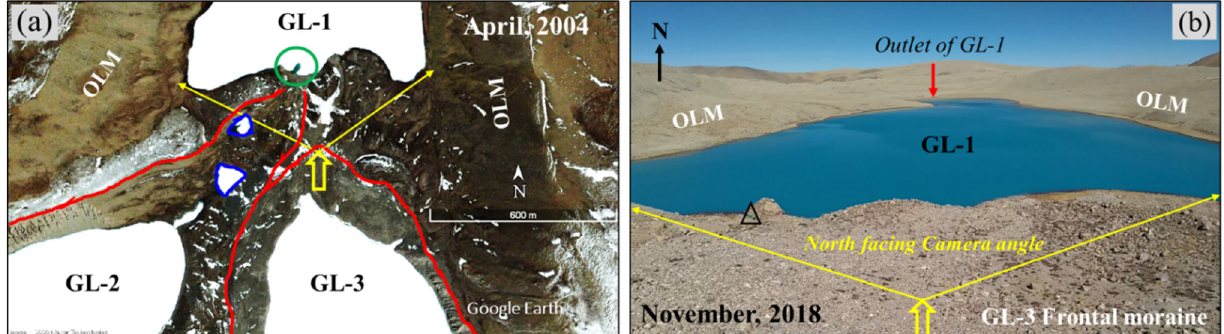
Figure 3. ( a ) Unfrozen water flow (green circle) observed near the inlet to GL-1 from GL-2 via small thermokarst lakes (demarcated in blue outlines) suggests a shallow subsurface drainage system. Note: Red lines are the crests of the recent latero-frontal moraines of GL-2 and GL-3; OLM, old lateral moraine. ( b ) Panoramic view of large outwash cone of the lower part of the GLC. Note: Buddhist temple in a black triangle inset represents the scale of the photo. [Photograph was taken from the GL-3 frontal moraine (blocked yellow arrow represent the camera sensor facing north) by Arindam Chowdhury in November